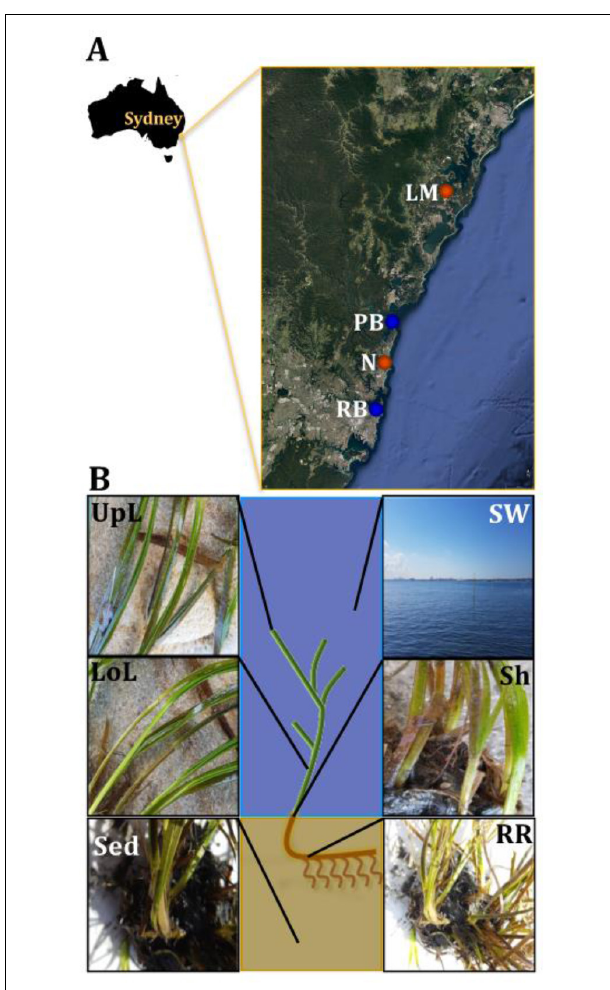
FIGURE 1 | Study sites and sampling strategy. Samples were collected between October and November 2015 across a region spanning 86 km of coastline in NSW, Australia (A) . Study sites included coastal (blue) and estuarine (orange) habitats, which were selected in accordance to habitat feature data (e.g., proximity to contamination sources and human activities) that was subsequently coupled with environmental parameters (e.g., water temperature and salinity) and genetic markers of anthropogenic pollution (i.e., intI1 ) to rank sites according to their specific conditions and level of impact. For details of the study sites selection criteria and categorization, see Supplementary Figure 1 and Supplementary Table 1 . At each site, samples from six different microenvironments within the plant (black fonts) and its surroundings (white fonts) were collected, based on the variety of conditions offered by these different niches (B) . UpL, upper leaf; LoL, lower leaf; Sh, sheath; RR, roots and rhizomes; Sed, sediment; SW, seawater;